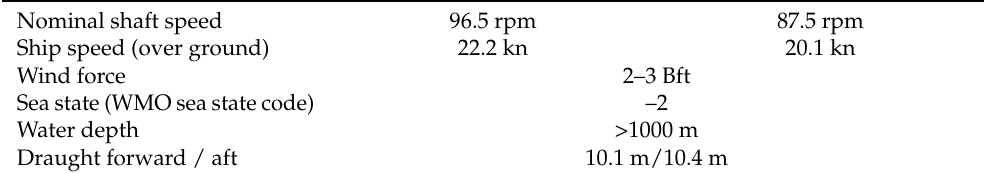
Table 2. Measuring